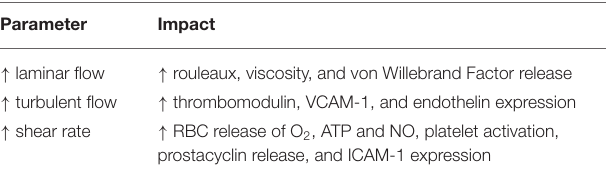
TABLE 1 | Influence of blood flow upon factors relevant to